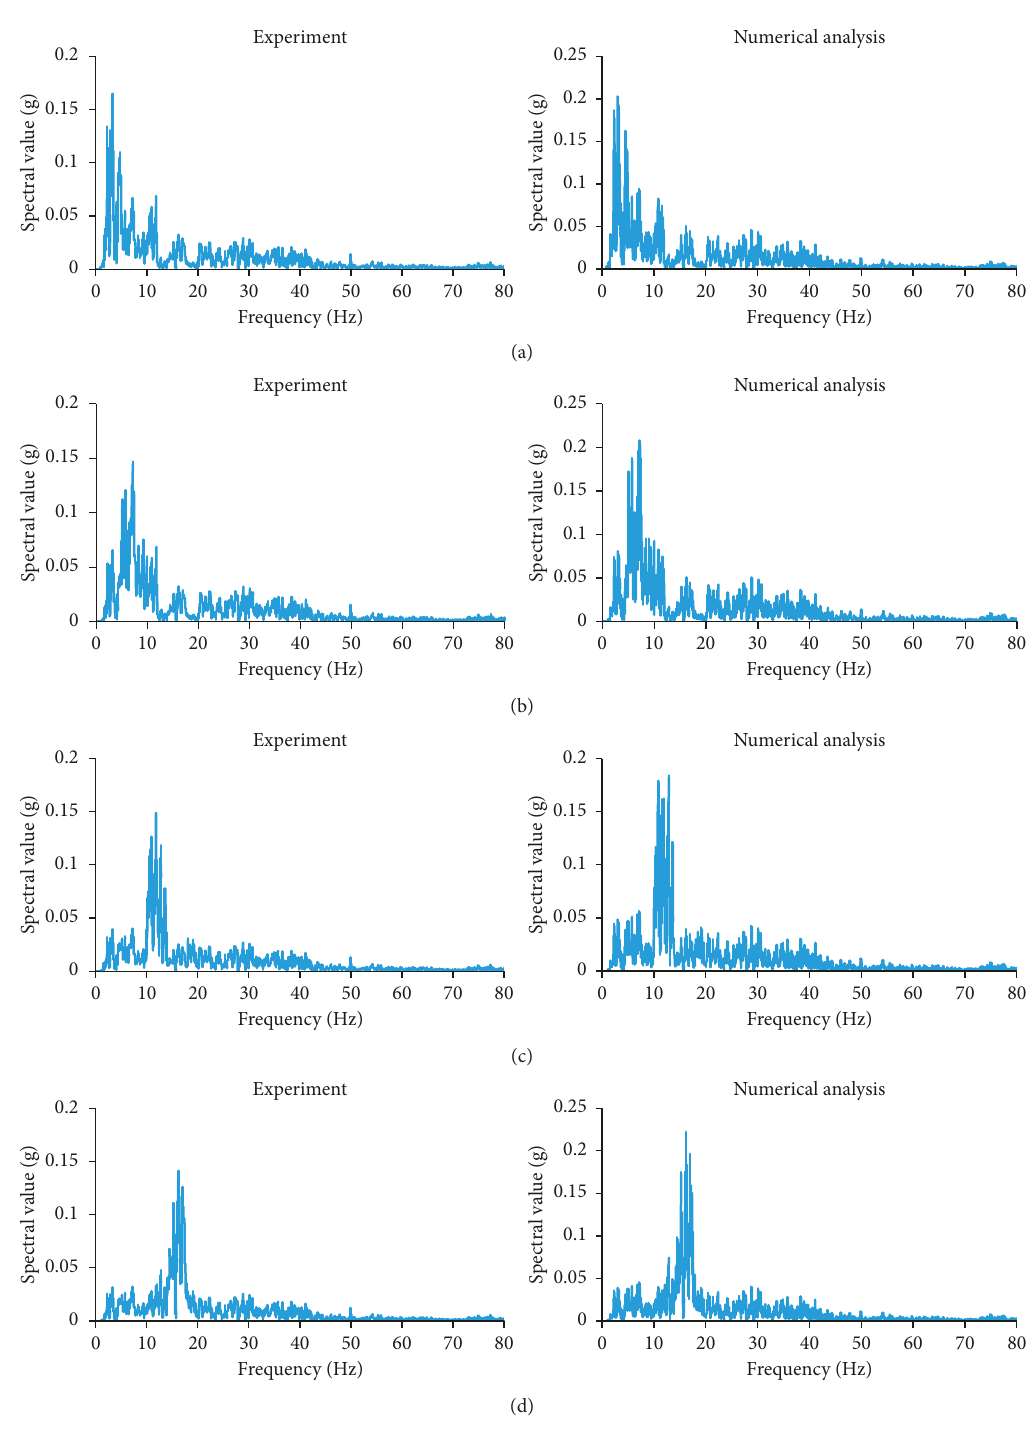
Figure 7: Fourier acceleration amplitude spectrums at point A7 under the Castaic wave (0.1 g). (a) Natural slope without vegetation. (b) Hinged block of slope. (c) Hinged block ecological slope. (d) Anchor + hinged block ecological